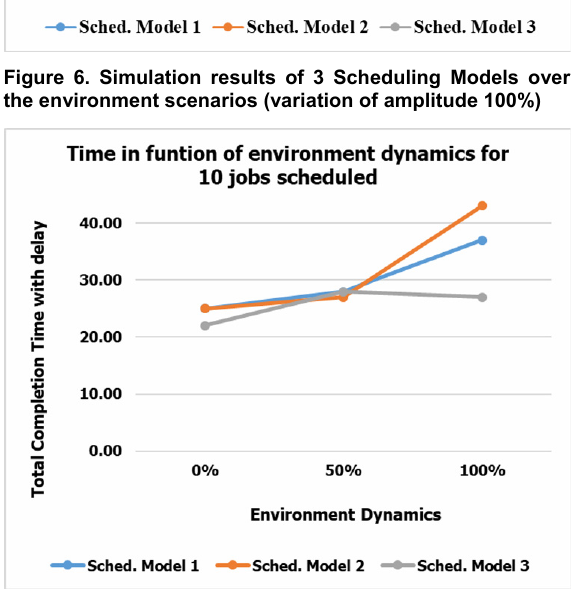
Figure 7. Effect of environment dynamics in total completion time over the 3 scheduling models for 10 jobs scheduled